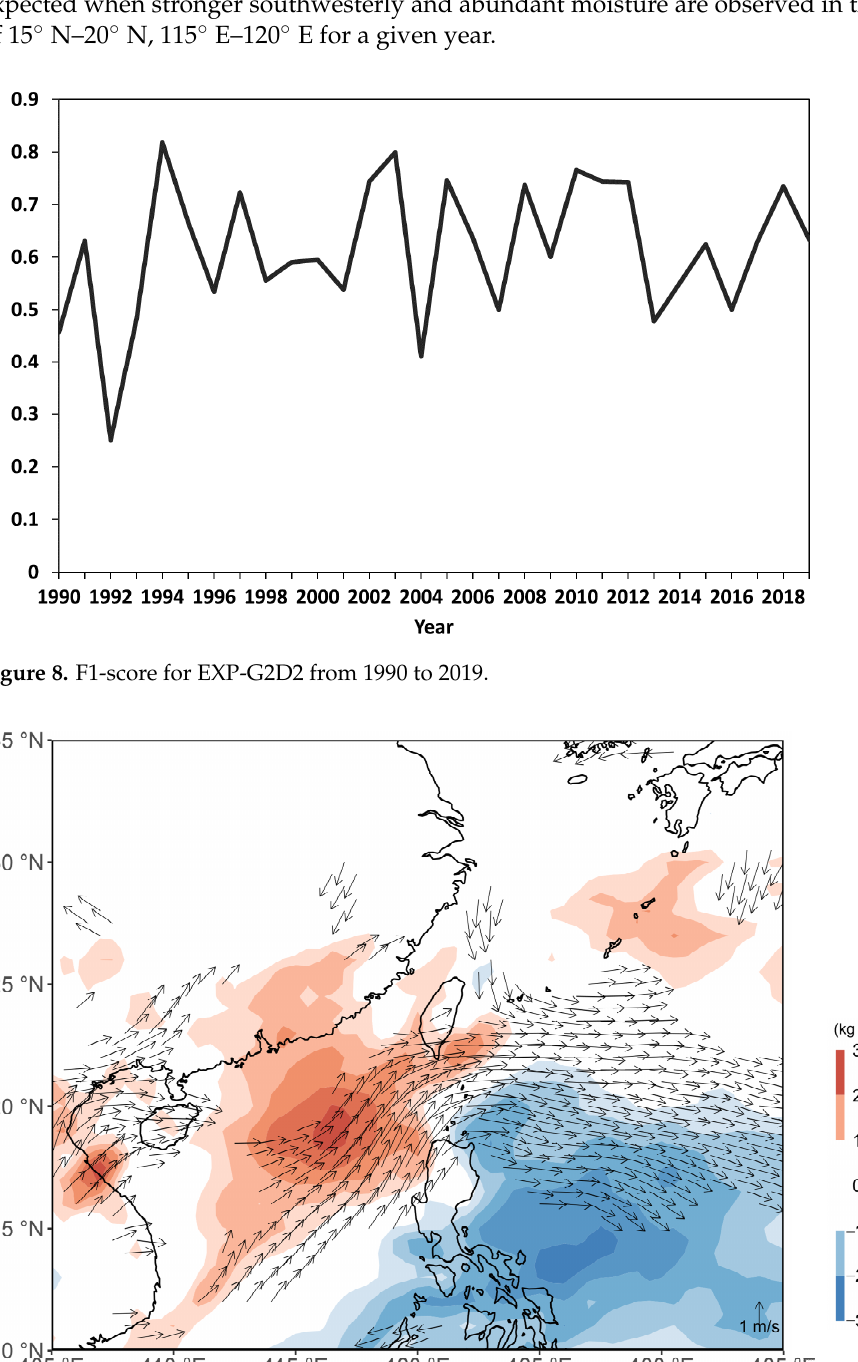
Figure 9. Composite for low-level (integrated from 1000 hPa to 850 hPa) water vapor flux (shadings) and 850 hPa winds (vectors) difference between the top 5 and the last 5 years of the F1-score from 1990 to 2019.